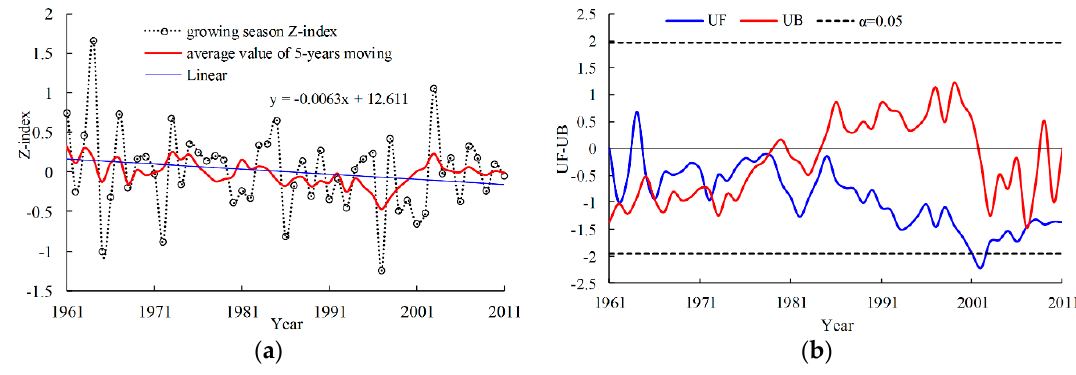
Figure 4. Trend of growing season Z ‐ index in the Huang ‐ Huai ‐ Hai River Basin: ( a ) growing season Z ‐ index; and ( b ) result of MK test.